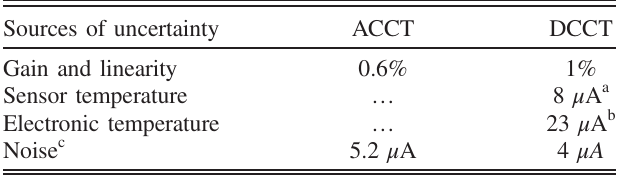
TABLE II. Main uncertainties in the measurement of the average intensities.